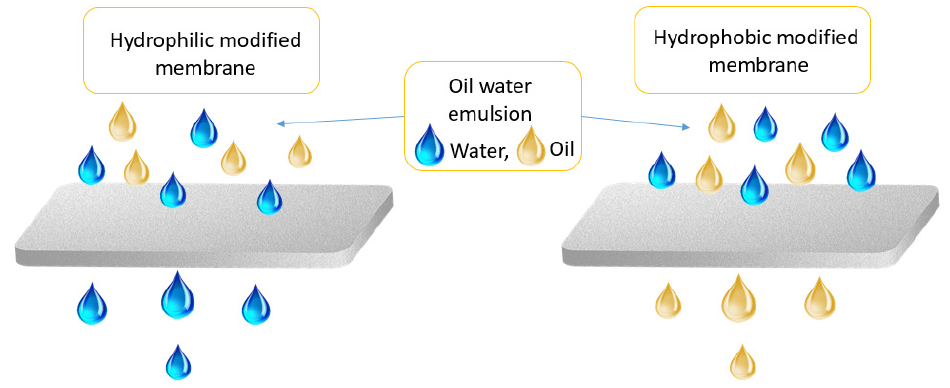
Figure 3. Schematic diagram of oil/water membrane separation process.